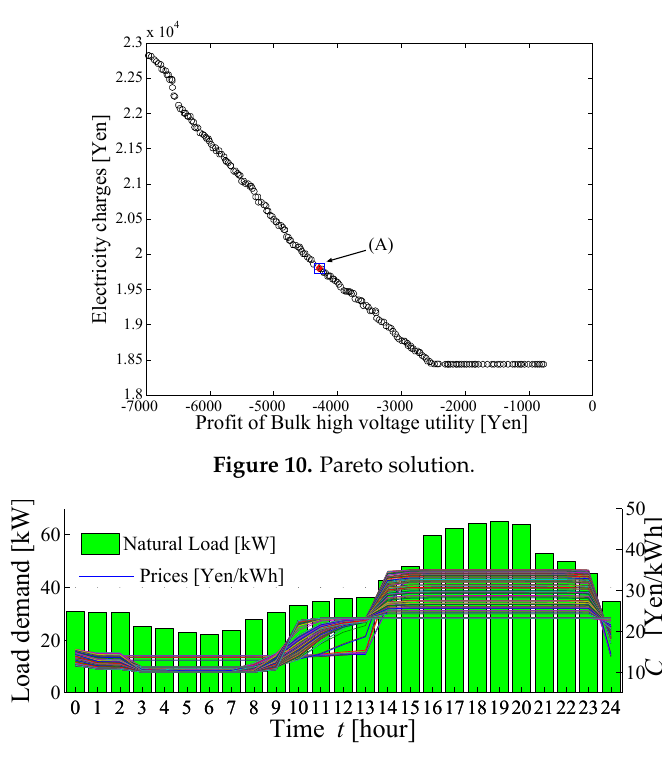
Figure 11. Predicted load and real-time prices.